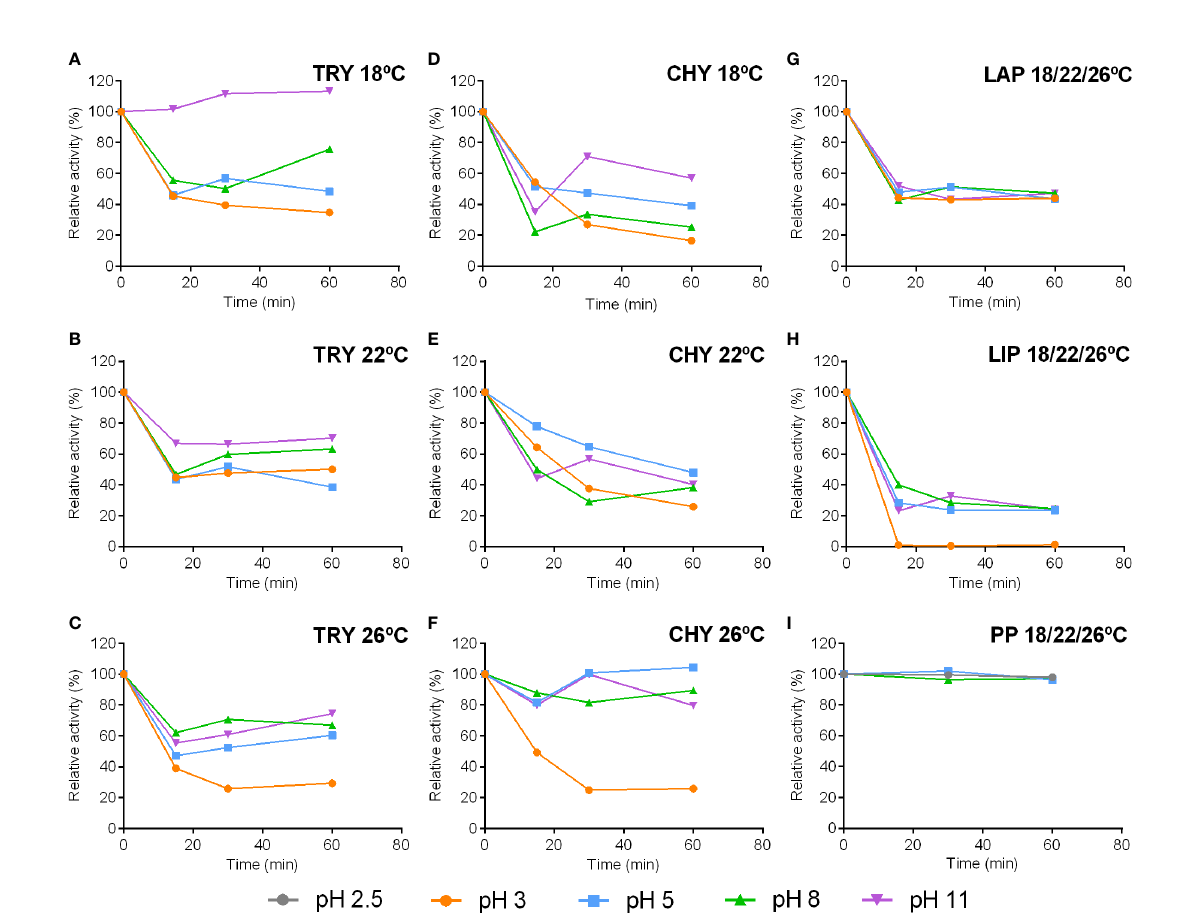
FIGURE 4 Stability of trypsin (TRY), chymotrypsin (CHY), leucine aminopeptidase (LAP), lipase (LIP) and pepsin (PP) activities from pyloric caeca and stomach of S. dumerili incubated at different pH. Leucine aminopeptidase, lipase and pepsin graphs represent mean values from all treatments. Individual graphs of pH stability for each enzyme in extracts coming from the different rearing temperatures are shown in the Supplementary Figure